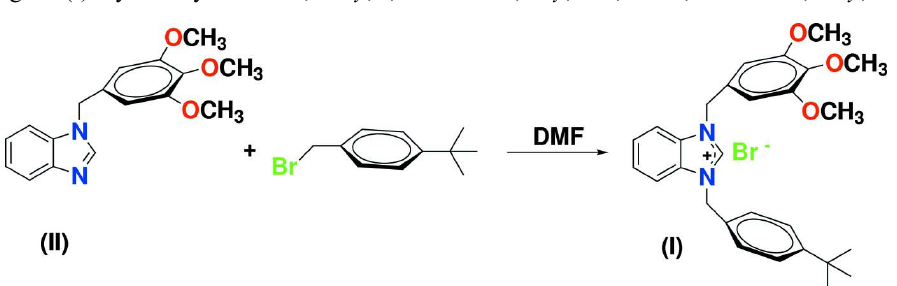
Hydrogen bonding for (I). Symmetry: O4A = x , 1 + y , z ; O4B =1 - x ,1 - y ,1 - z ; Br1A, etc . = 1 - x , 2 - y , 1 - z .